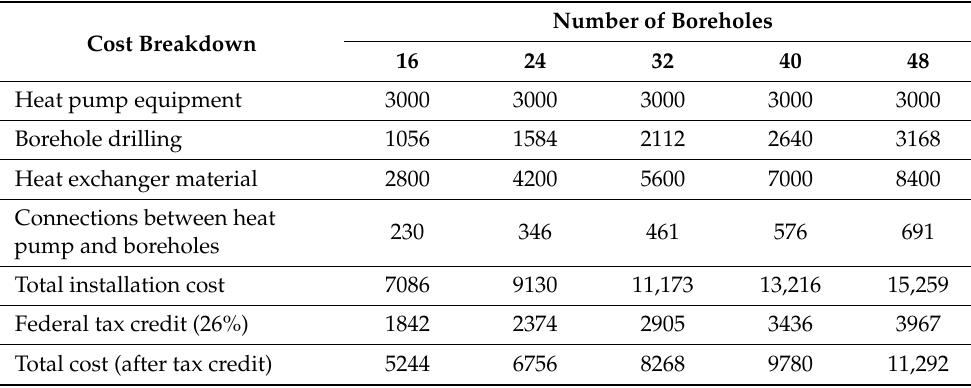
Table 6. Total cost of S-GSHP systems using 6.7 m (22 ft) deep boreholes.